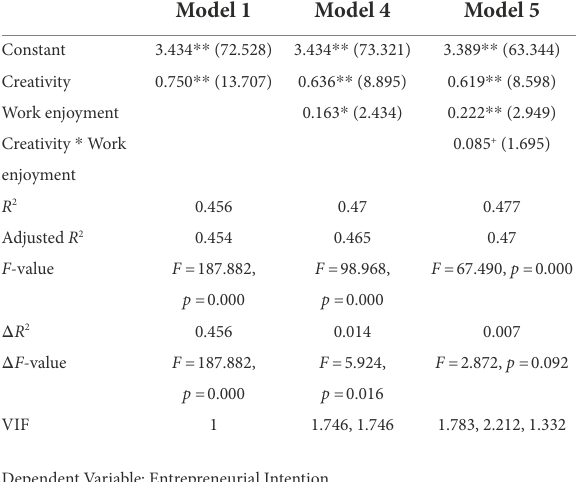
TABLE 6 Moderating effect analysis (flow – work enjoyment; N = 226).